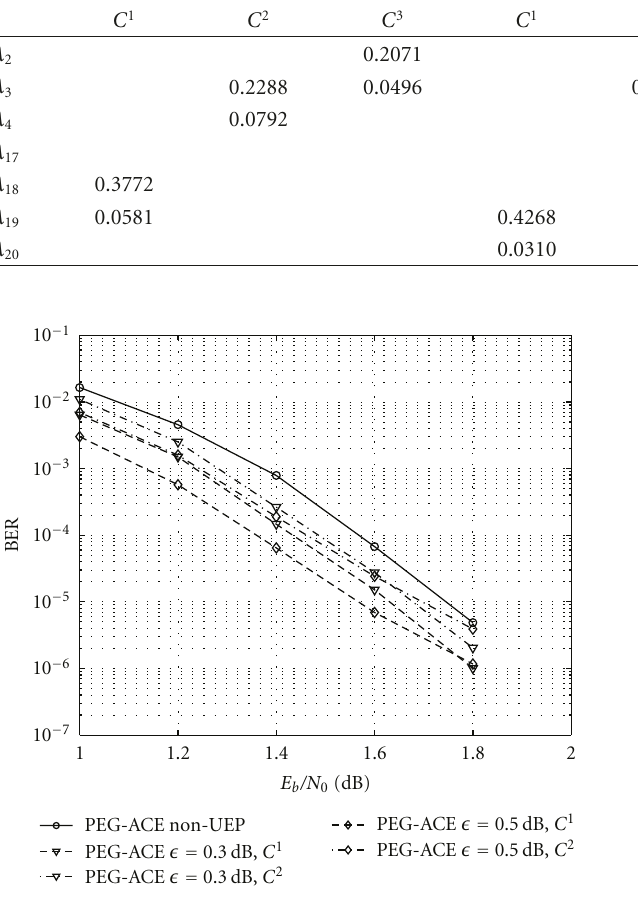
Figure 2: BER performance of three PEG-ACE codes with length n = 2048 and allowed d v max = 20. The average BER is shown for the non-UEP code, while the BERs of both C 1 and C 2 are shown for the UEP codes. Both classes of the UEP codes perform better than the non-UEP code.